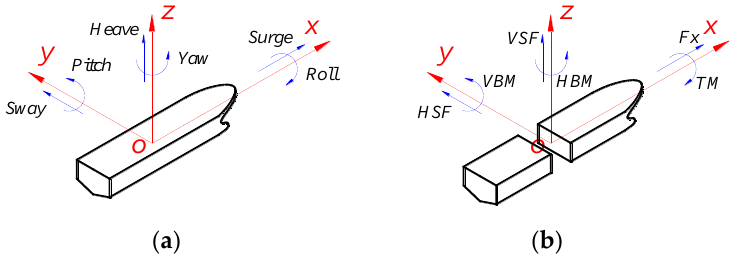
Figure 2. Definition of global motions and loads: ( a ) motion components; and ( b ) sectional load components.